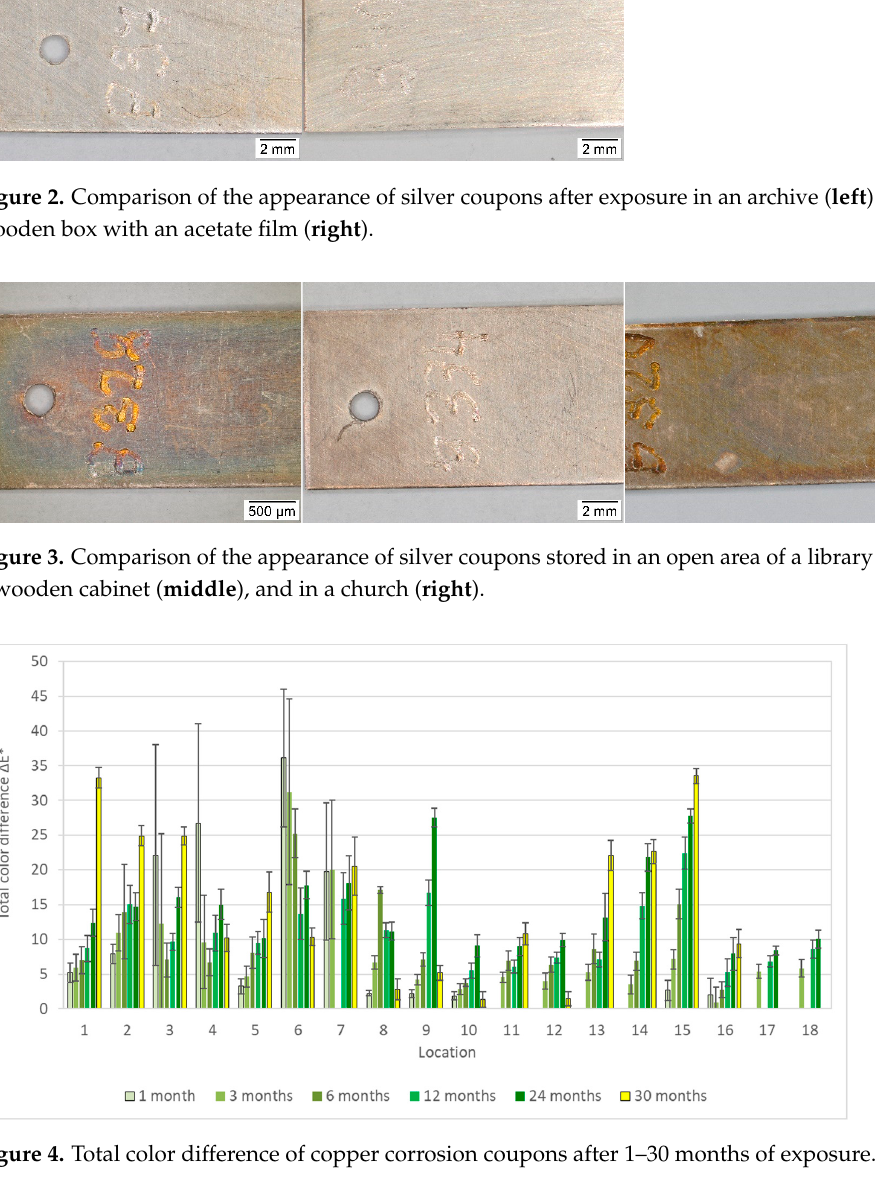
Figure 4. Total color difference of copper corrosion coupons after 1–30 months of exposure.